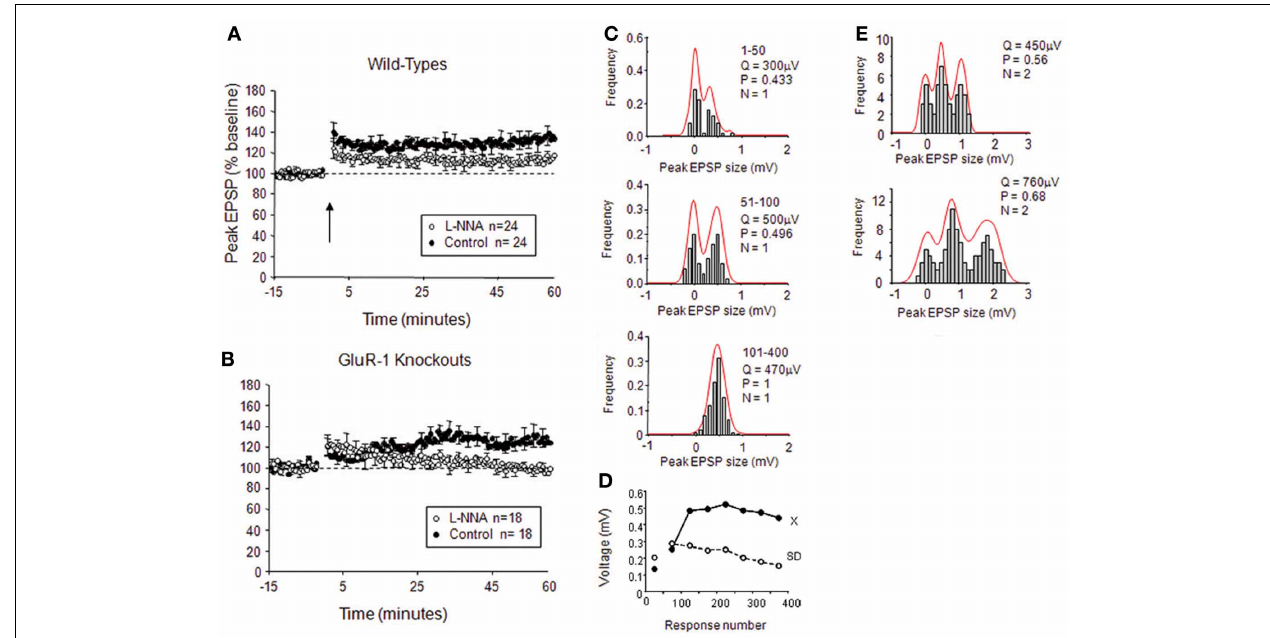
FIGURE 6 | Effects of NO on release-probability in cortical LTP. (A) Intracellular application of the NOS antagonist L-NNA reduces but does not abolish spike pairing LTP in wild-type mice. (B) Intracellular application of L-NNA abolishes LTP in mice lacking the GluA1 subunit of the AMPA receptor. (C) Examples of quantal analysis from a single release site input onto a layer II/III neuron from a wild-type mouse; note that LTP occurs by an increase in release-probability and quantal amplitude. (D) The plot of EPSP amplitude and